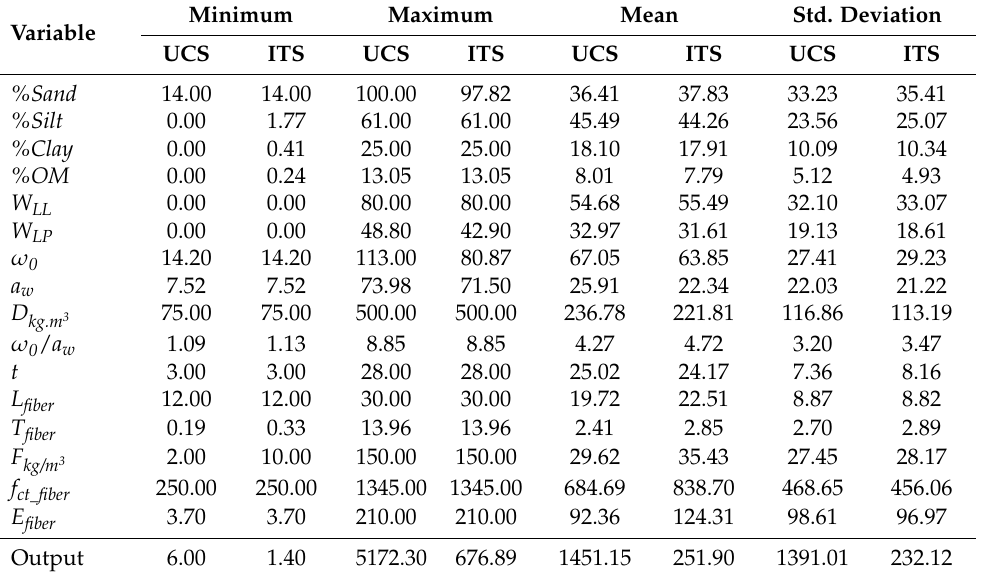
Table 1. A summary of the main statistics of the input and output variables used in mechanical properties prediction of reinforced soil-binder-water mixtures with